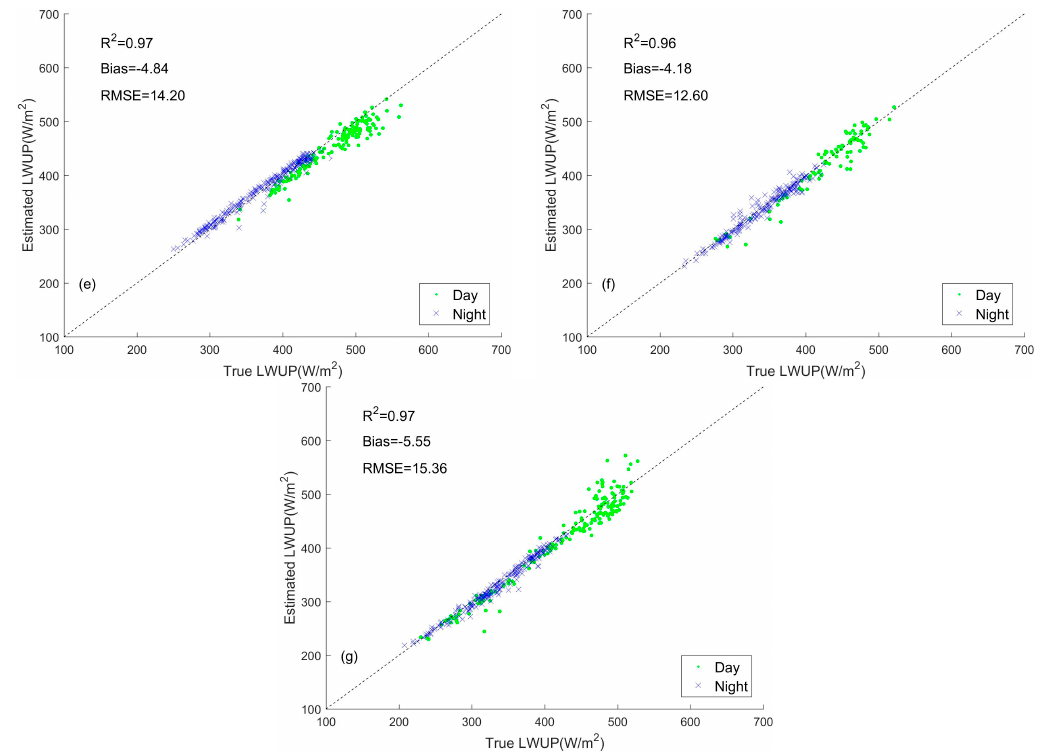
Figure 4. Validation results of the MARS model at SURFRAD sites. ( a ) Bondville_IL. ( b ) Boulder_CO. ( c ) Desert_Rock_NV. ( d ) Fort_Peck_MT. ( e ) Goodwin_Creek_MS. ( f ) Penn_State_PA. ( g ) Sioux_Falls_SD.